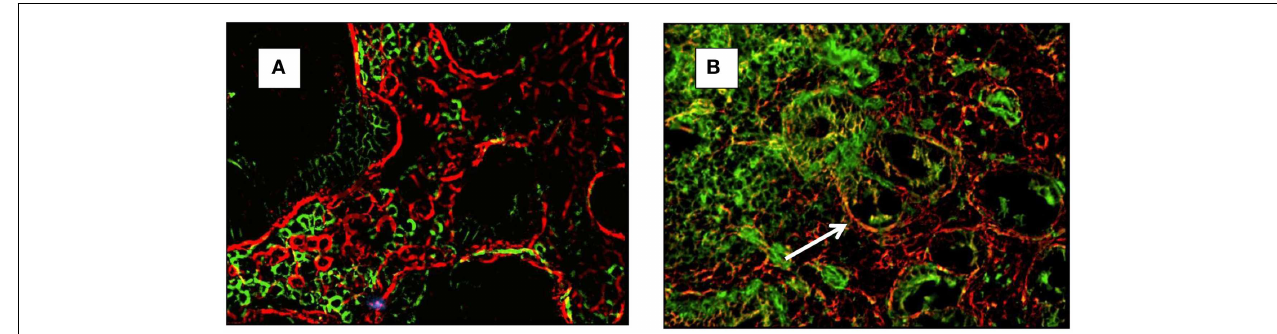
FIGURE 1 | Small-bowel mucosal immunofluorescence staining of IgA (green) and transglutaminase-2 (red) and co-localization of IgA andTG2 in yellow (arrow) . In (A) a healthy control (no co-localization), in (B) a celiac patient with evidence of co-localization